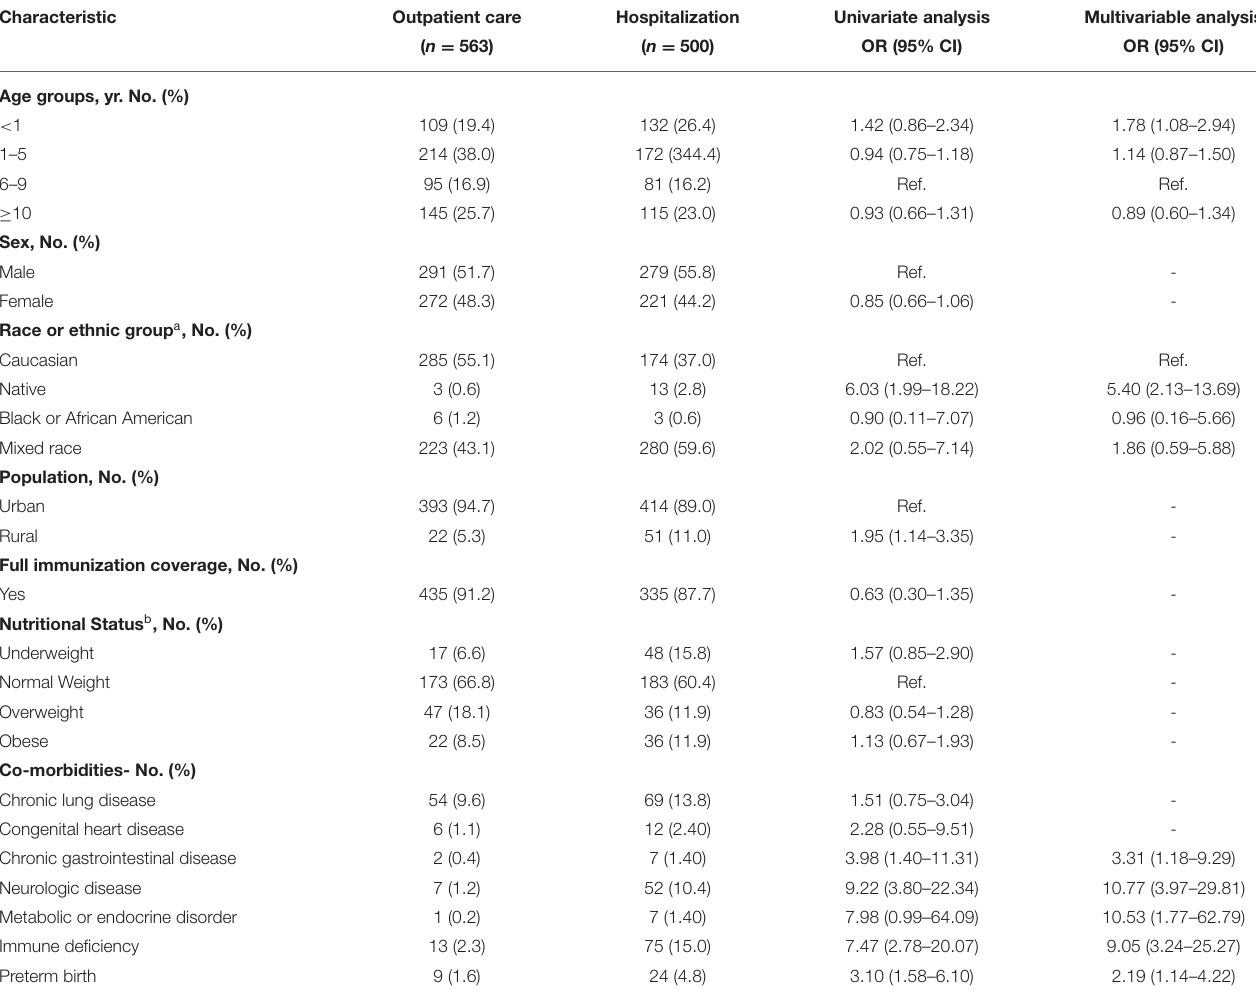
TABLE 2 | Demographic and underlying medical conditions associated with hospitalization (general ward and intensive care), among pediatric patients with COVID-19 using multiple imputation chained equations for missing data. Characteristic Outpatient care Hospitalization Univariate